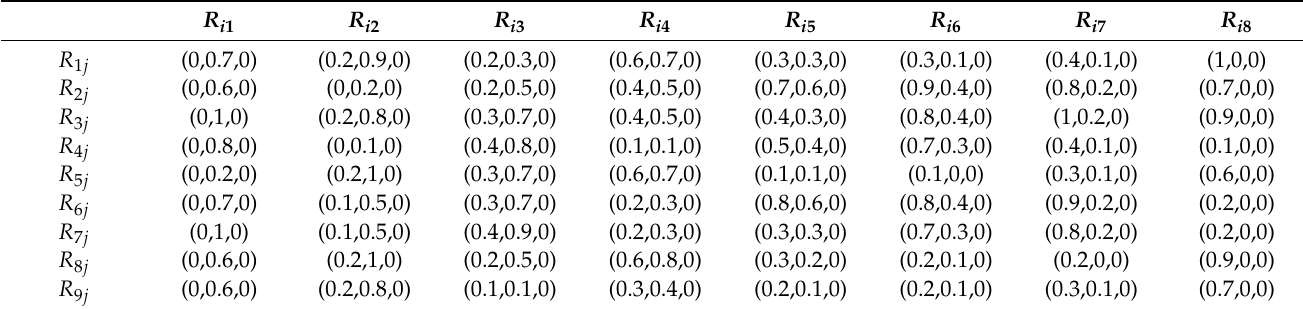
Table 5. Coordinates of the reference points.